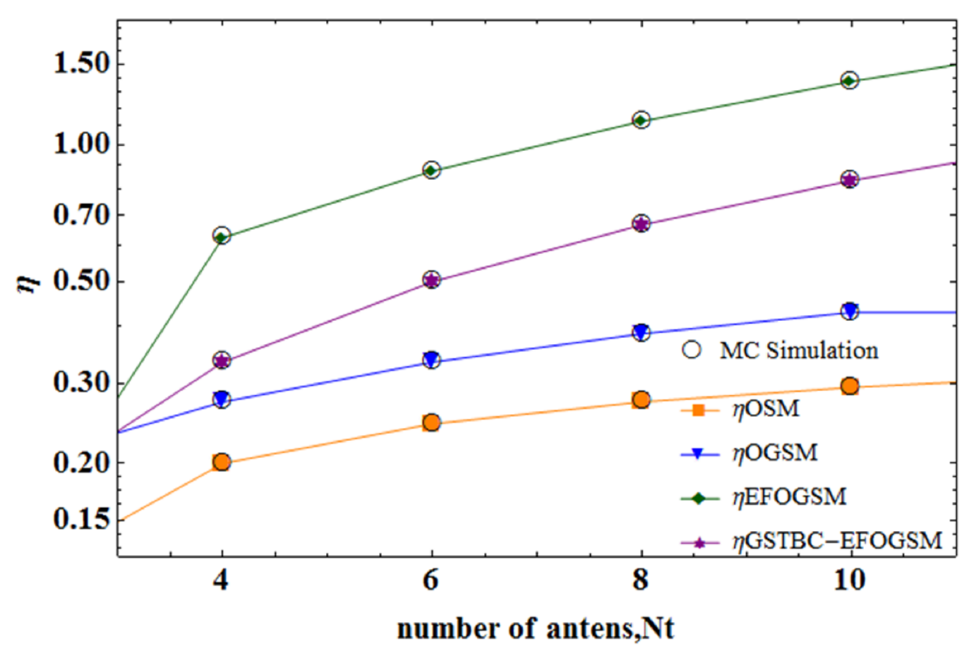
Figure 7. Energy efficiency η under different optical spatial modulation systems.